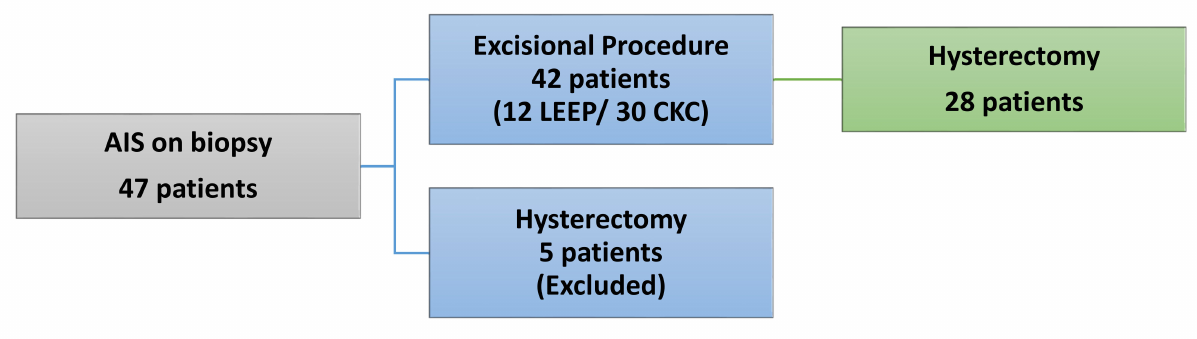
Figure 1. Flow diagram of patients who underwent excisional procedures followed by definitive hysterectomy.